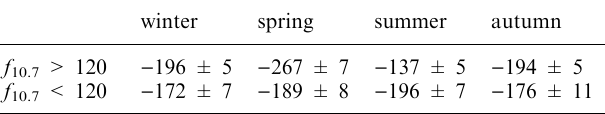
Table 4. Nighttime maximum equatorward values in m (cid:225) s ) 1